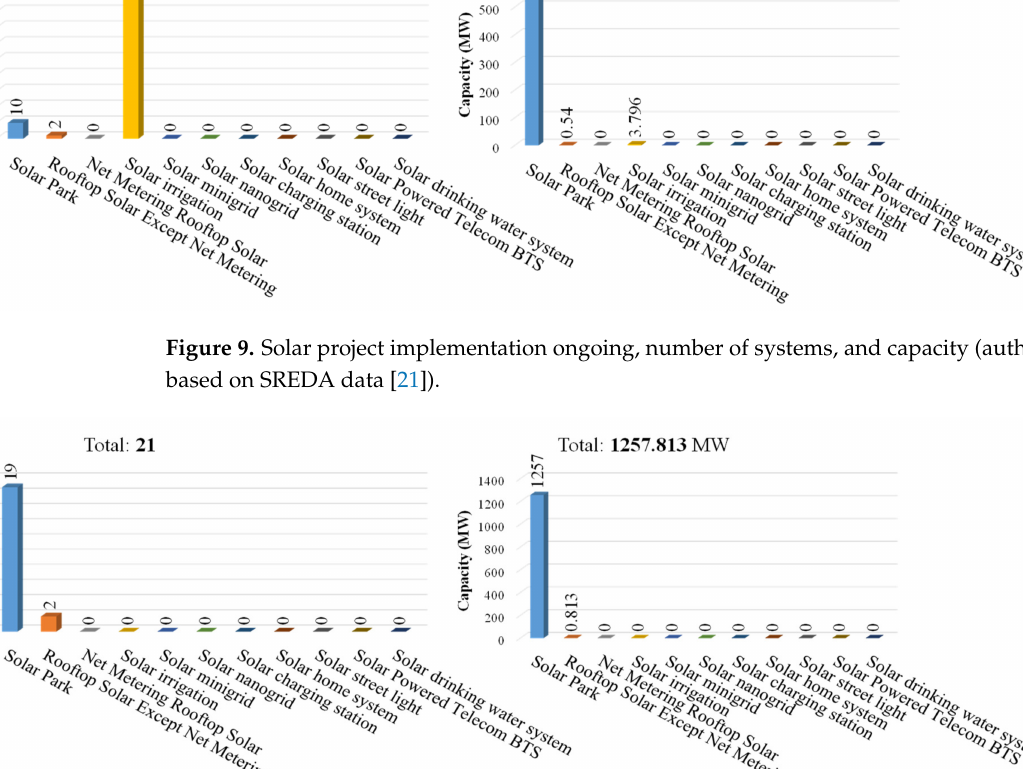
Figure 10. Solar project under planning, number of systems, and capacity (authors’ creation based on SREDA data